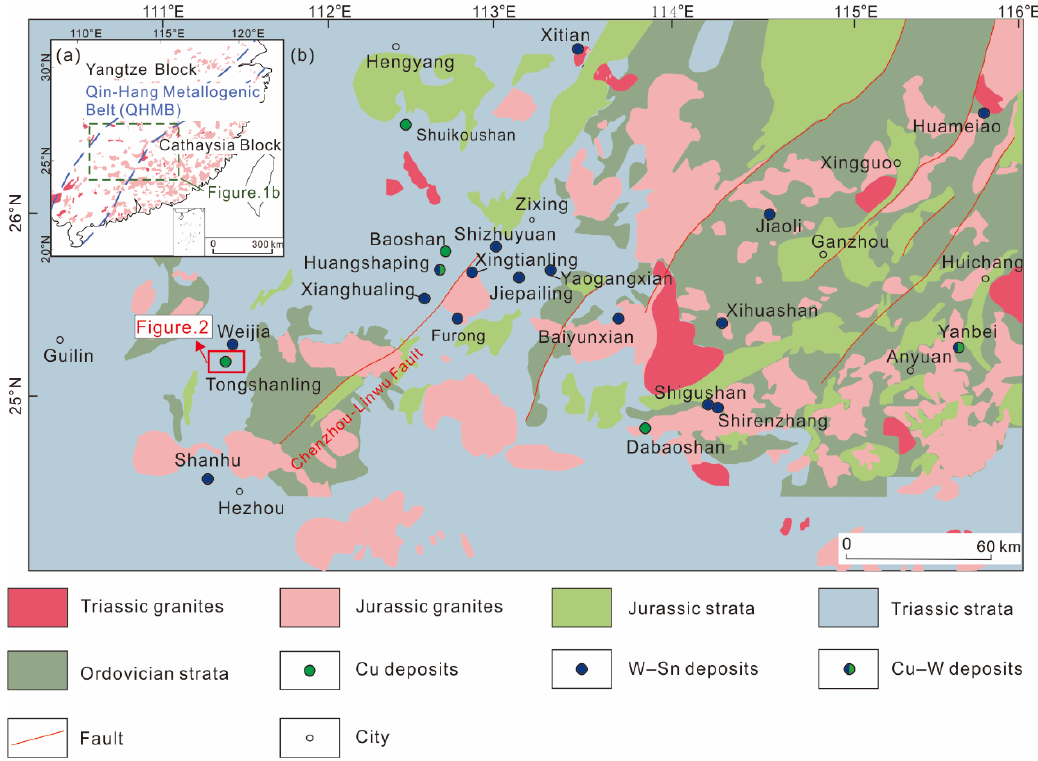
Figure 1. Distribution of ( a ) Triassic and Jurassic granitoids in South China, ( b ) the Cu and W-Sn ore deposits location of the Qin–Hang ore belt (after [3,12,20]).